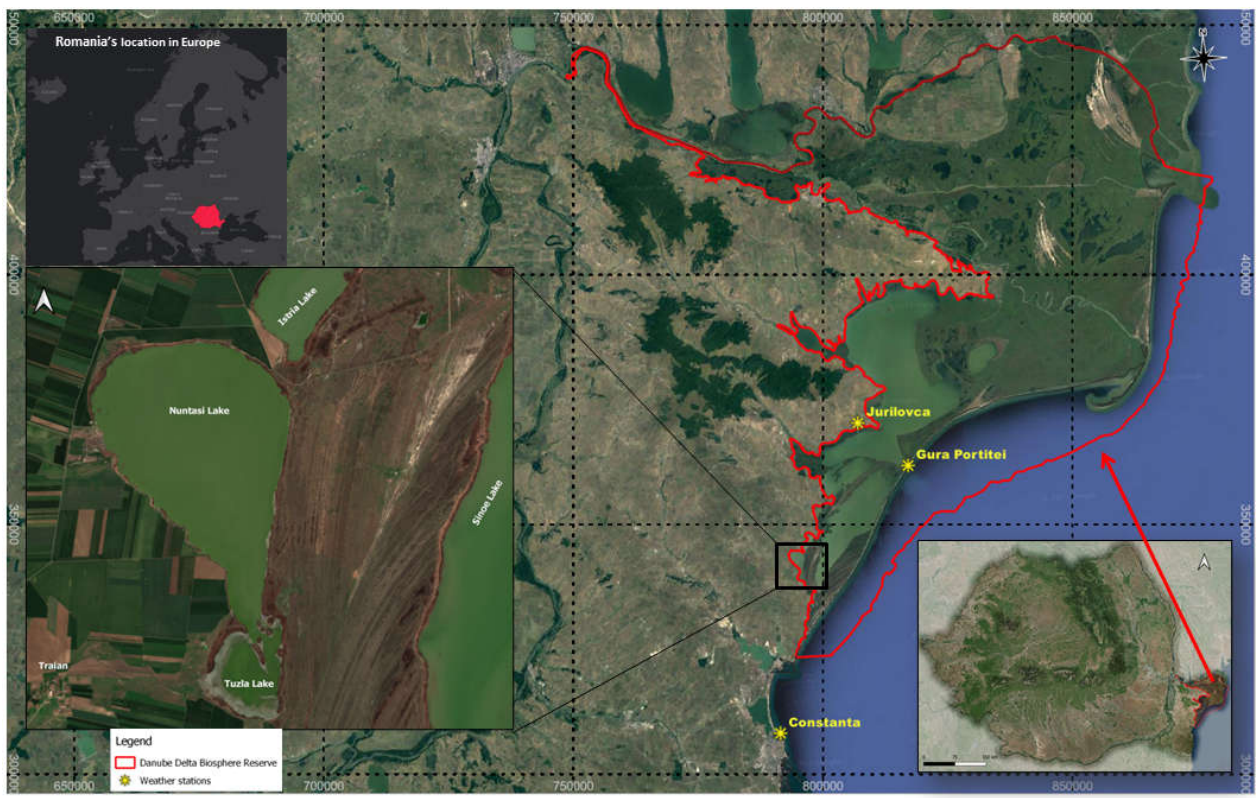
Figure 1. Location of Nuntași–Tuzla complex inside the Danube Delta Biosphere Reserve.